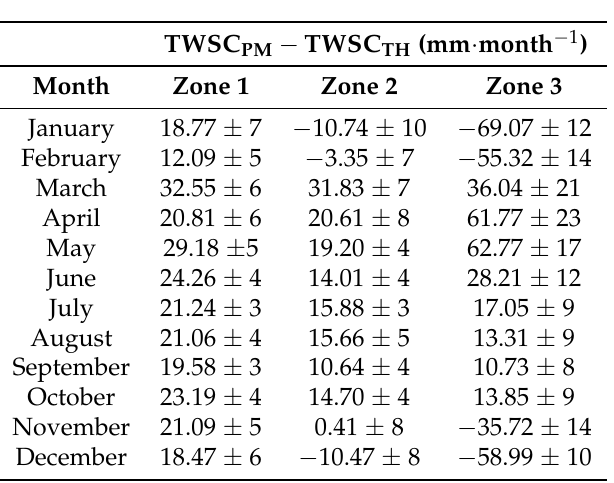
Table 4. Difference between TWSC PM and TWSC TH